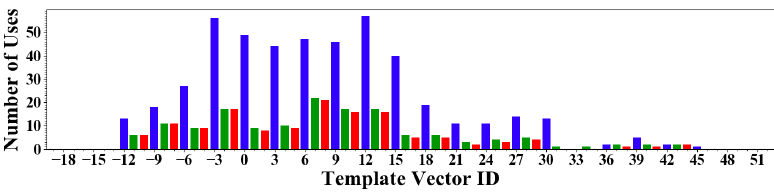
Figure 10: The Number of Uses of Each Template